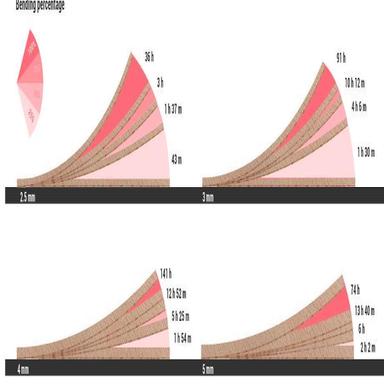
Visual representation of Table 2, showing the time required to reach different bending percentages.